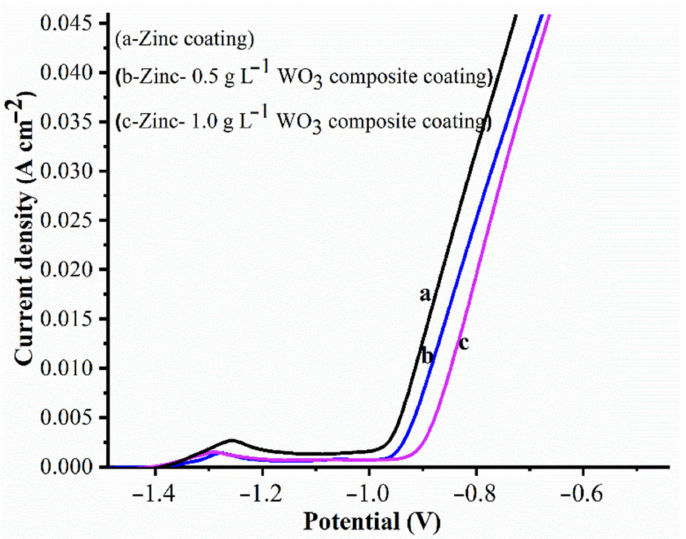
Figure 11. Anodic polarization curves of Zn and Zn–WO 3 composite coatings samples in 3.5% NaCl solution.